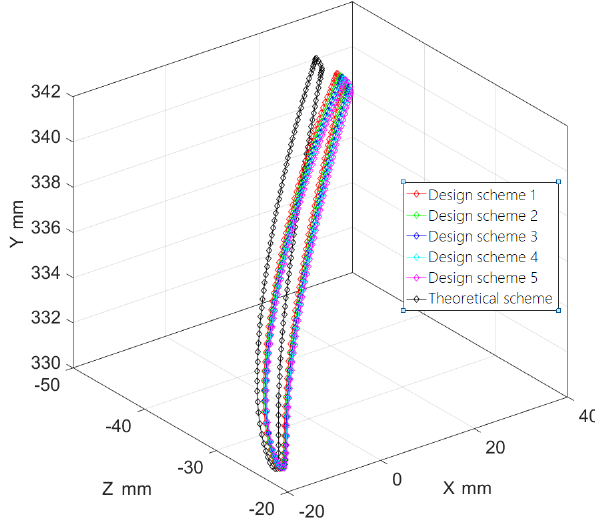
Figure 2. Spatial positions of the nodes at the blade tip.